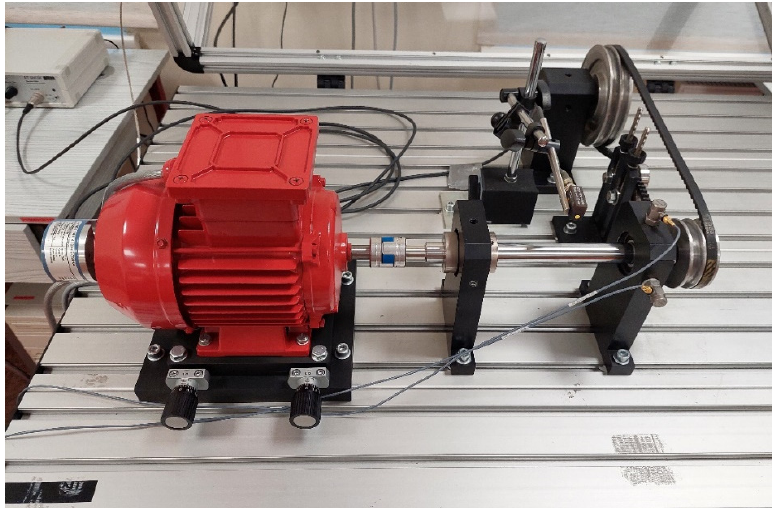
Figure 6. Bearing testing.